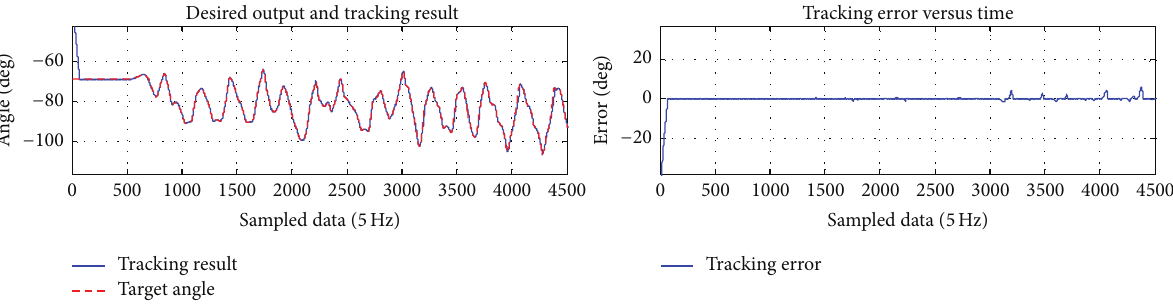
Figure 11: Tracking error of predesigned fuzzy surface with proposed ANFIS.